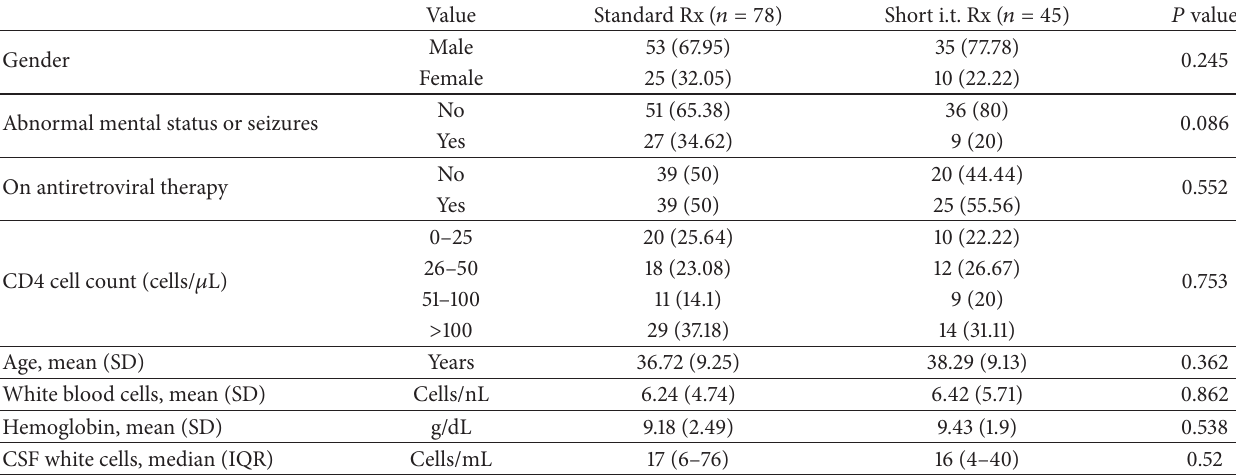
Table 1: Baseline characteristics by treatment group.